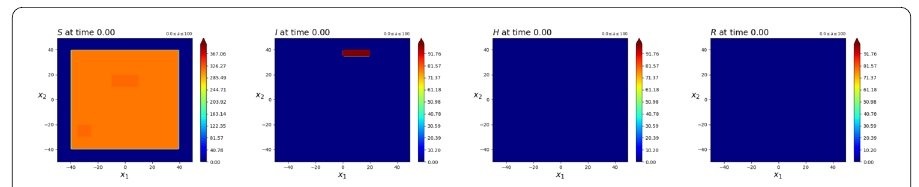
Figure 8 Contour plots of the initial datum as a function of the space variable for the “CareHomes” integration. Note that the total distribution of the S population is approximately uniform, while a small groups of infected individuals are present in the top part of the graph. Neither H nor R individuals are now present